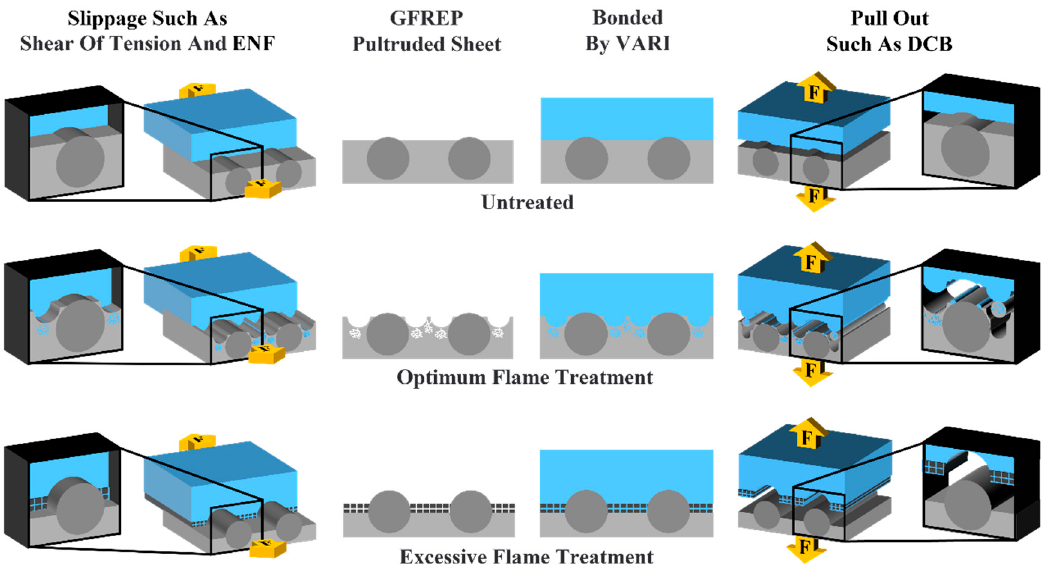
Figure 14. Schematic diagram of the whole process of flame treatment, infusion, and experimental loading on the surface of the GF/EP pultrusion sheet.